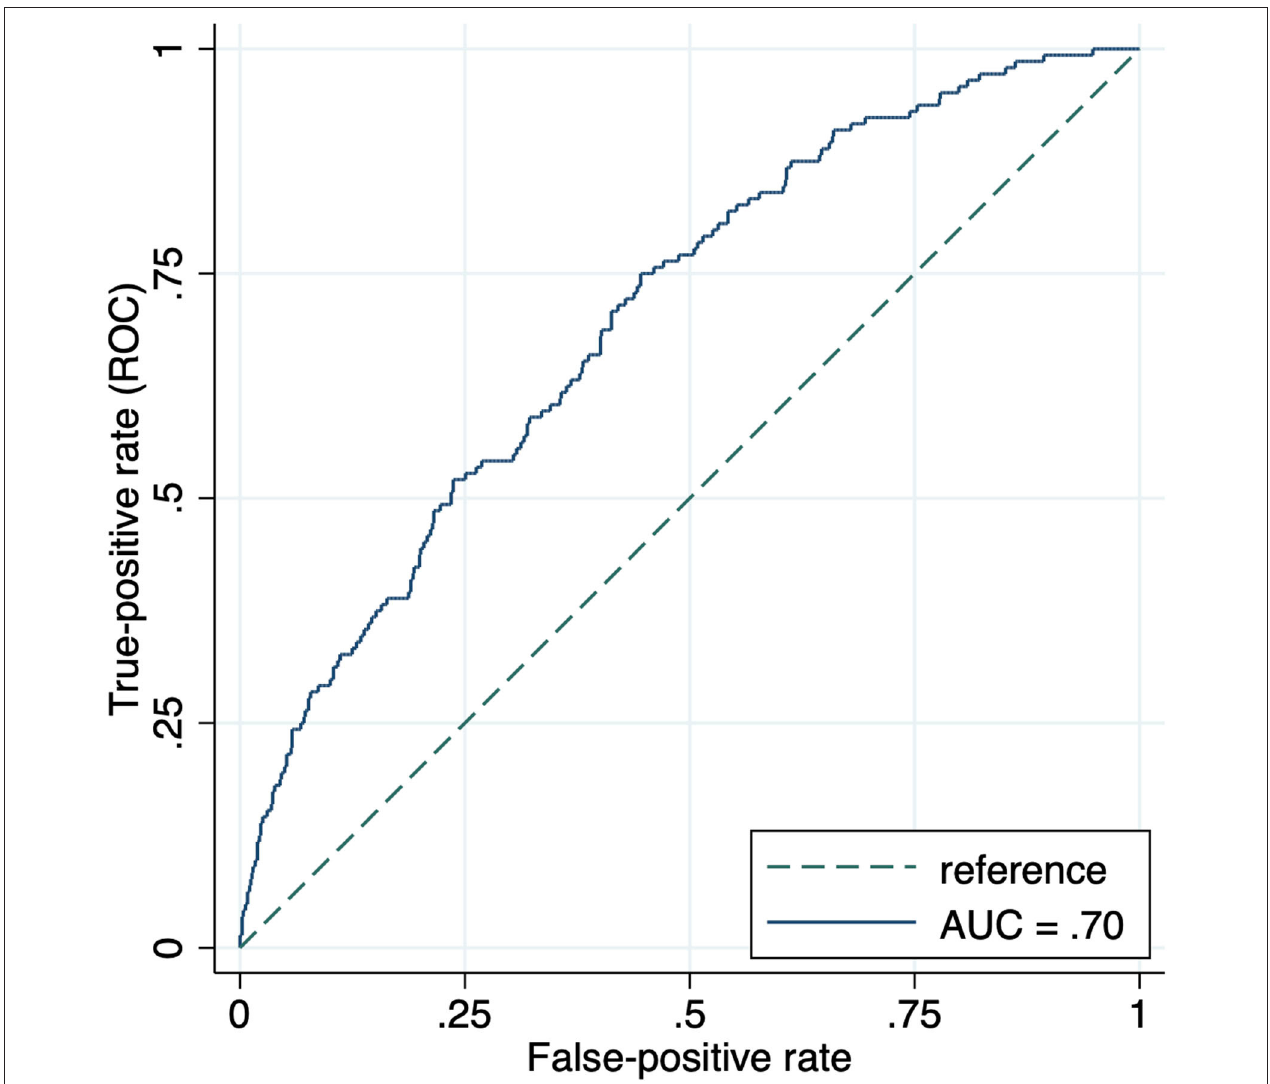
FIGURE 1 | Receiver-operating characteristic curve for performance of the OxRec model in predicting violent reoffending outcome in the Tajik cohort within 1 year of release from prison. AUC, area under the receiver operating characteristic curve; ROC, receiver operating characteristic